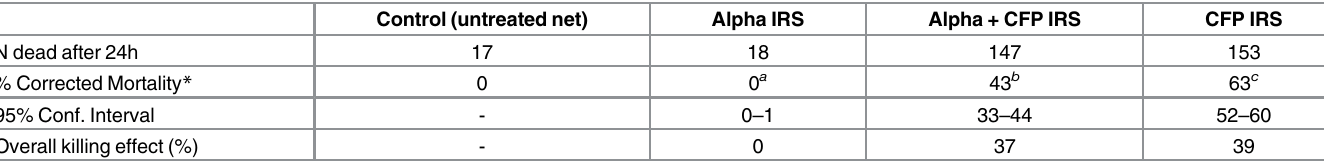
Table 4. Killing effect of wild pyrethroid resistant An gambiae sl in experimental huts in Cove, Benin.